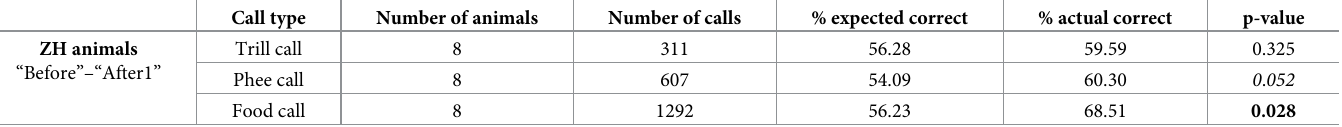
Table 1. Short term environmental accommodation. In a sample of eight common marmosets from the ZH population, one of three call types showed a significant dif- ference and one a strong trend to differ in the acoustic properties in the week immediately after translocation, when compared to the calls before the translocation. % of expected calls indicate the amount of correct classification if classification were random, % actual correct the amount of correct classification the pDFA reached with the data. Significant p-values are indicated in bold, trends in